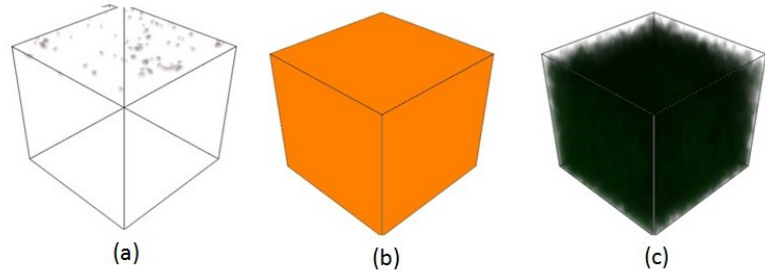
Figure 5. Three-dimensional distributions of ions on the FA surface treated with H 2 SO 4 (1 × 10 −3 mol/L) and oleate (2 × 10 −4 mol/L): ( a ) SO 4− , ( b ) PO 3− , and ( c ) CaO − .